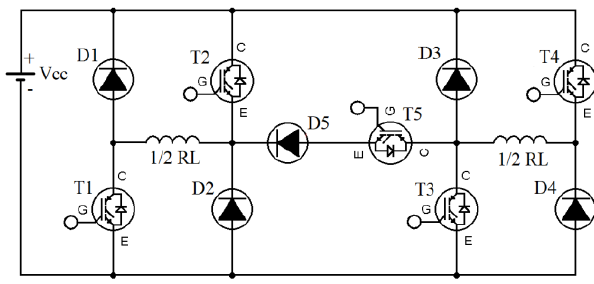
Fig. 1. One channel of a SRM converter enabling the winding configuration